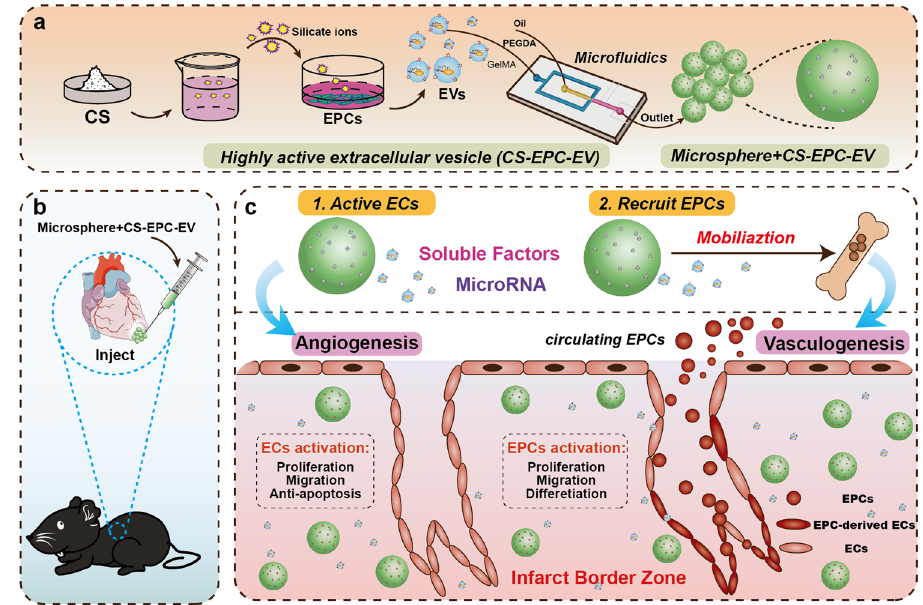
Fig.1|High-ef fi ciencyengineeringofhighlyactiveextracellularvesiclesbythe treatmentofendothelialprogenitorcells(EPCs)withsilicateionsderivedfrom bioactiveceramicsformyocardialinfarctiontherapythroughenhancementof revascularization of infarcted tissues. a EPCs were induced by calcium silicate (CS) ions to secrete highly active extracellular vesicles (CS-EPC-EV), and micro- spheres loaded with highly active extracellular vesicles (microsphere+CS-EPC-EVs) were prepared by micro fl uidic technology. b In situ injection of microsphere+CS- EPC-EVs at the site of myocardial infarction in mice to repair myocardial injury.